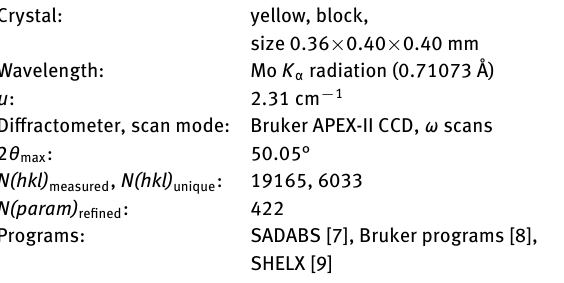
Table 1: Data collection and handling.